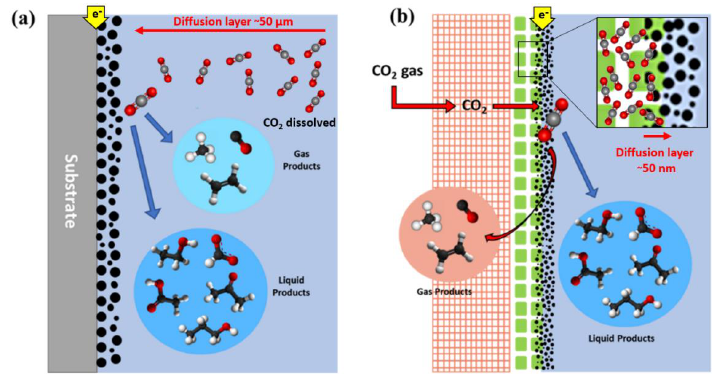
Figure 2. Principles of operation of aqueous-fed and gas-fed CO 2 electrolysers. ( a ) In aqueous-fed electrolysers, CO 2 diffuses from the bulk of the electrolyte to the surface of a traditional catalytic electrode, e.g. nanoparticles supported on a solid non-porous substrate. During operation, the diffusion layer can be 50 μm thick. As a result, the conversion of CO 2 to gas and liquid products is diffusion-limited. Both product types are released in the electrolyte. ( b ) In gas-fed electrolysers, CO 2 gas is transported to the CL from the back of the GDE; then, a diffusion layer as thin as 50 nm can be established near the catalyst. This results in a high CO 2 concentration gradient across the diffusion layer, delivering CO 2 reactant much faster to the catalysts. Gas products are dispatched to the gas side of the GDE, whilst liquid products remain in the electrolyte solution.